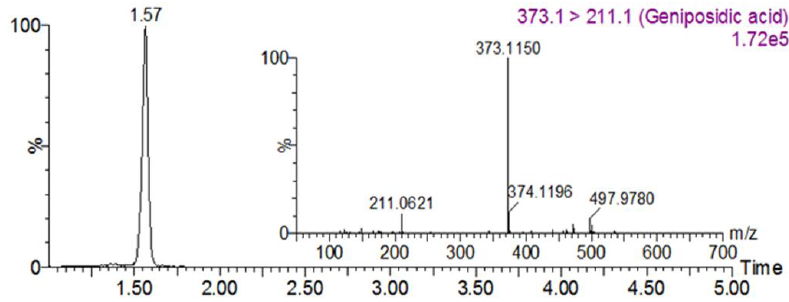
Figure 1. Chromatogram of Eucommia ulmoides Oliv. (EU) extracts.